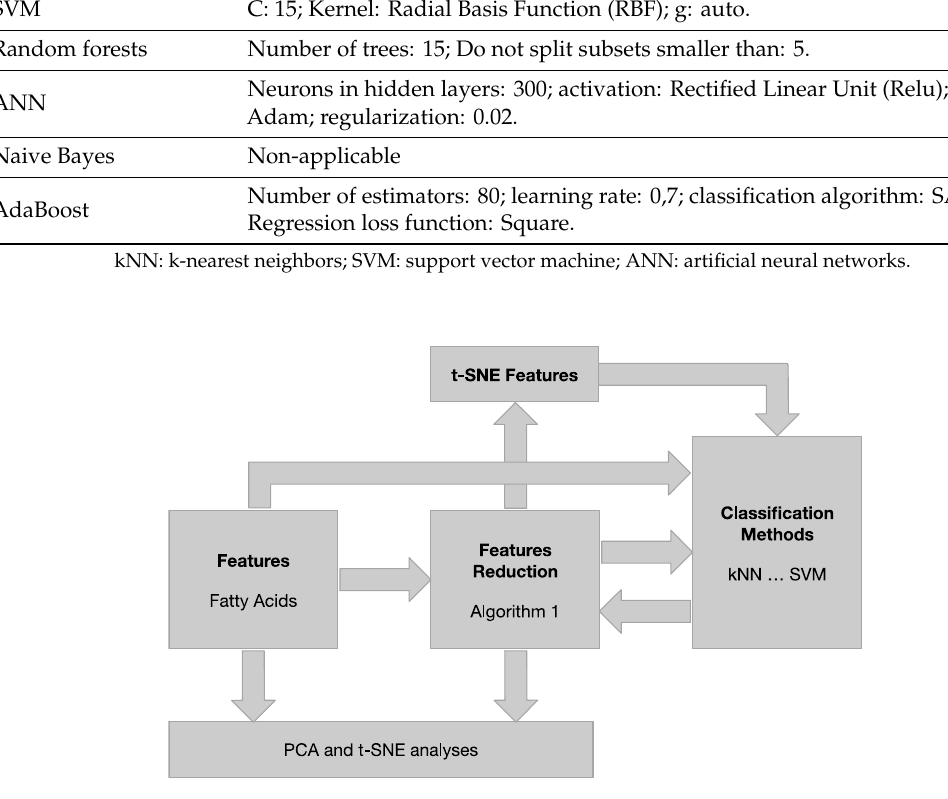
Figure 1. Main process pipeline. PCA: principal components analysis; t-SNE: t-distributed stochastic neighbor embedding.